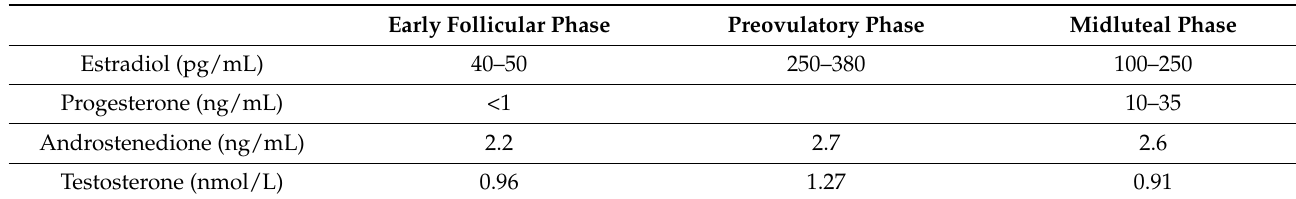
Table 1. Normal values of sex hormones in different phases of the menstrual cycle.